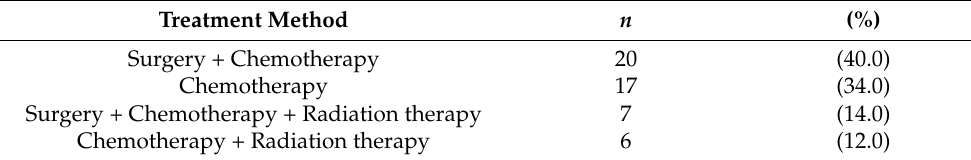
Table 3. Percentage of combinations of treatment modalities (multiple answers allowed) ( n =